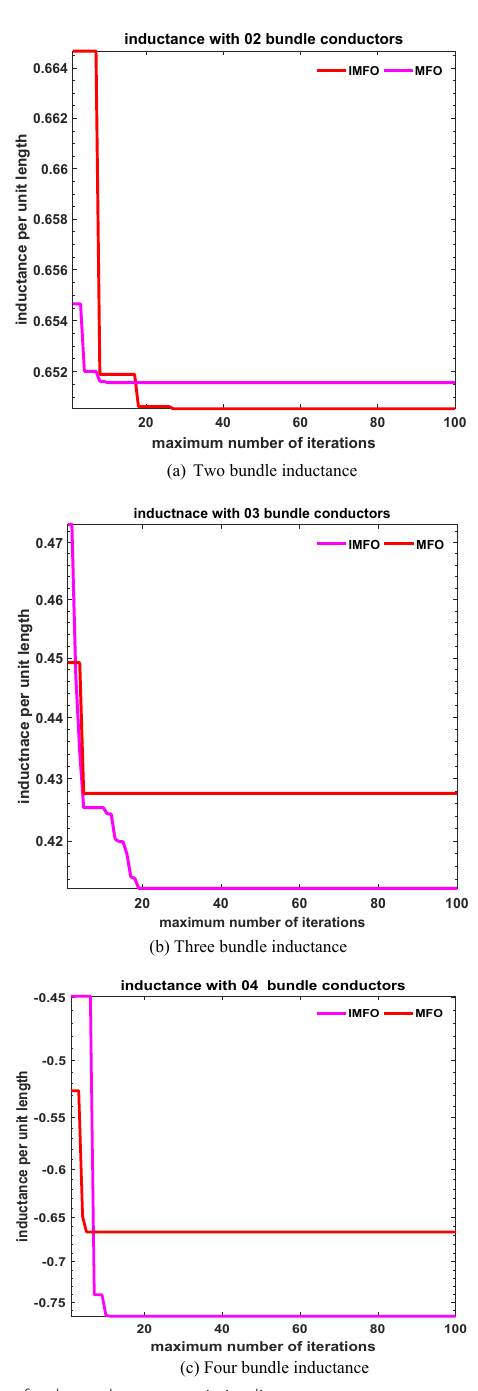
Fig. 4 Convergence curve for three-phase transmission